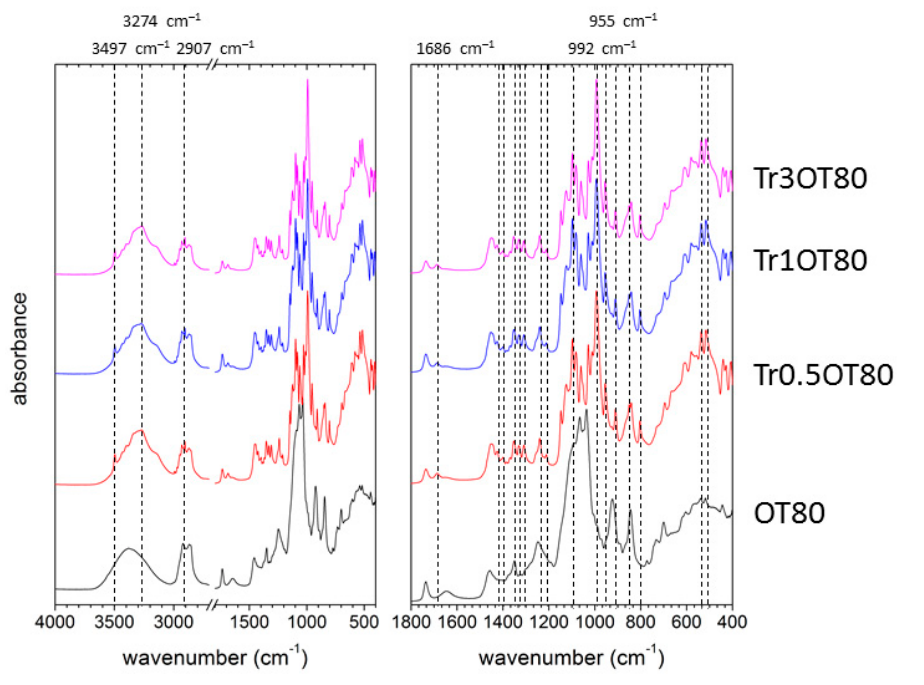
Figure 8. ATR FTIR spectra of the trehalose-containing carrageenan films with the addition of essential oil (0.5 g of carrageenan, Tween 80).